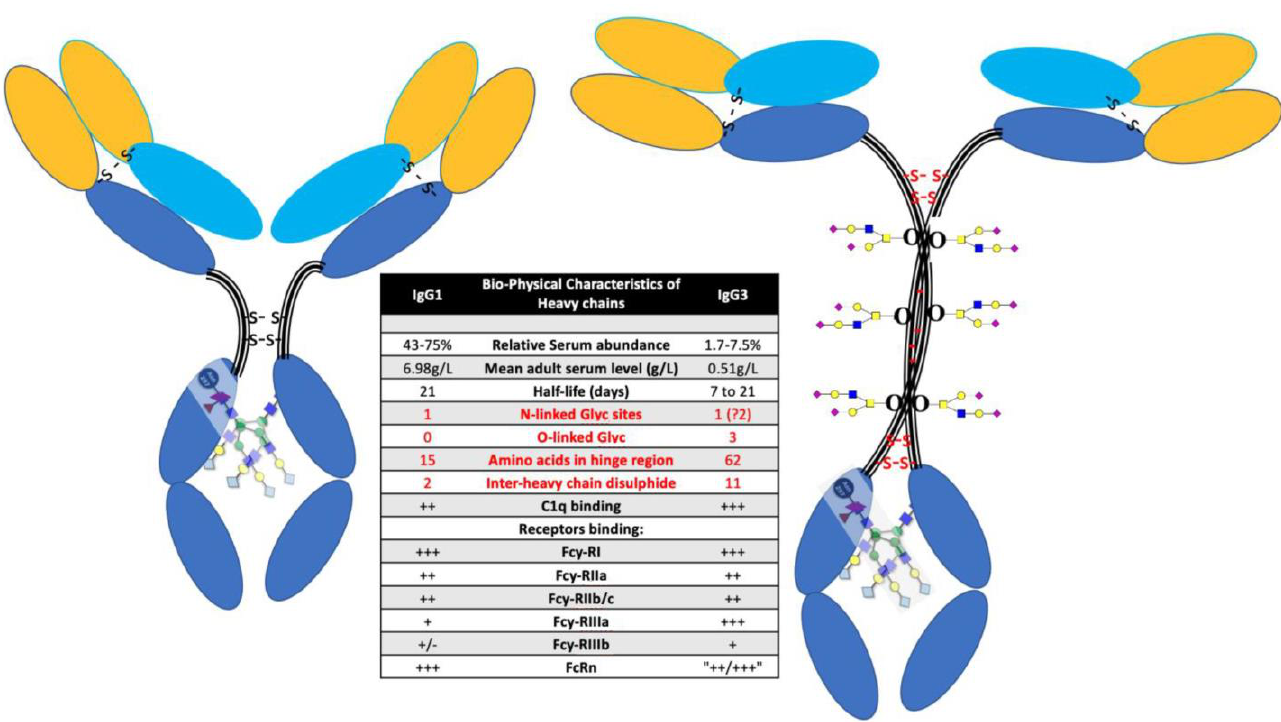
Figure 3. Diagrammatic representation of IgG1 ( left ) and IgG3 ( right ) illustrating the differences in heavy chain structure with special reference to the larger neck domain and the O-linked glycosyla- tion sites found there. Affinity binding: – , none; +,weak; ++, strong; and +++, very strong. The importance of sialic acid residues as a target for attachment of Influenza is well known [38,39]. However, human coronaviruses OC43 and HKU1 also bind to 9- O -acety- lated sialic acids via a conserved receptor-binding site in spike protein domain A [40]. Found within the N-terminal Domain (NTD) of S1 subunit of SARS-CoV-2, this sialic acid residue binding domain has been postulated to be the key feature of coronavirus zoonotic transfer [41]. Its role in corona virus attachment as an airborne to respiratory mucosal epithelia is now recognised [42 – 45]. Furthermore, so strong and specific is the Spike com- plexes binding to sialic acid that one group has used terminally sialylated glycans as a solid phase for SARS-CoV-2 capture in a lateral flow diagnostic device [46]. It is not a large binding domain and may be a charge specific attraction. Terminal sialic acids confer a strong net negative charge, whilst other terminal glycan saccharides do not. Similarly, some of the AGE glycation products deposit a structured negative charge to albumin [47]. This may be a major component of the biochemistry of glycated HSA and hyperglycosyl- ated (and/or glycated) IgG3 binding by SARS-CoV-2 prefusion Spike protein (see Figure 4).